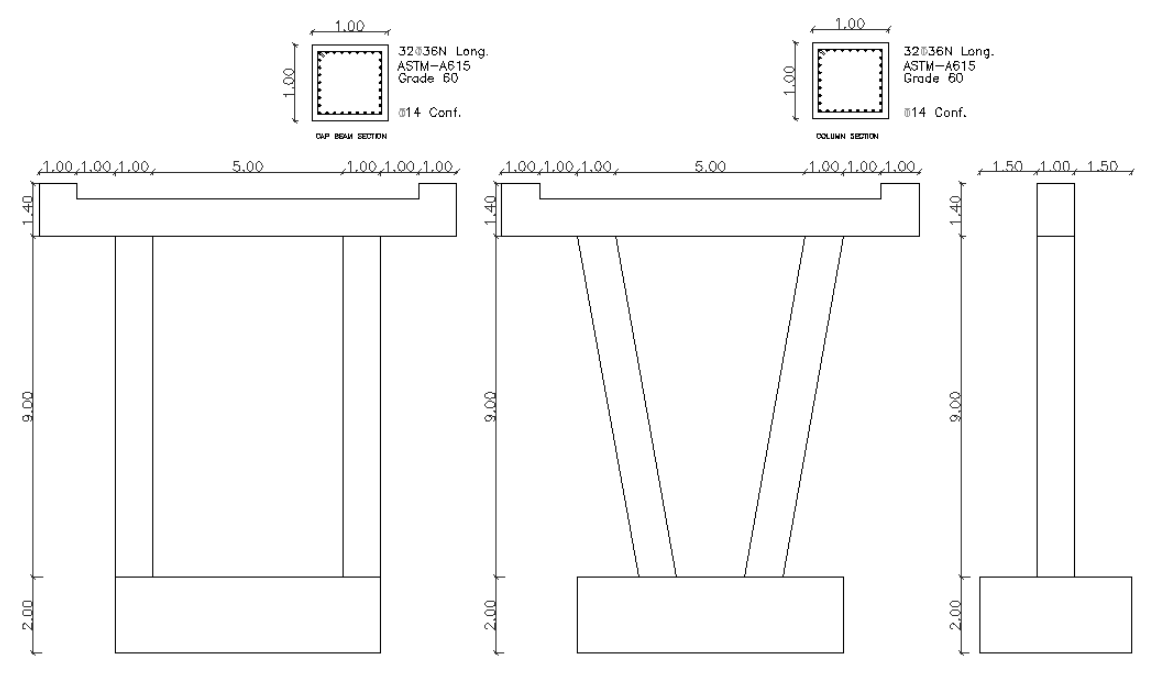
Fig. 1. The specifications of the